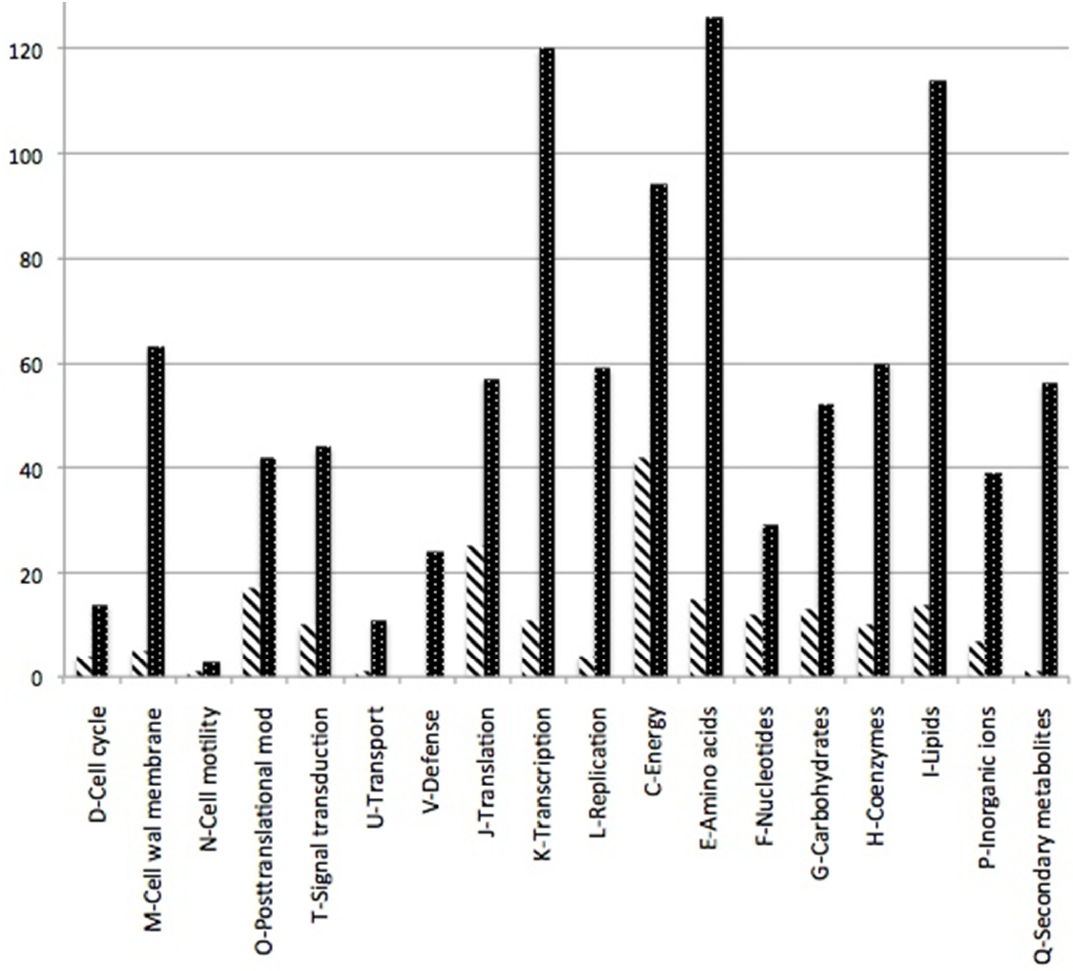
Figure 2. Histogram of over- and underabundant proteins coding genes (FC > 2 hatched; FC < 0.5 dotted) assigned to COGs. Undefined categories and those with one or less occurrences were omitted.